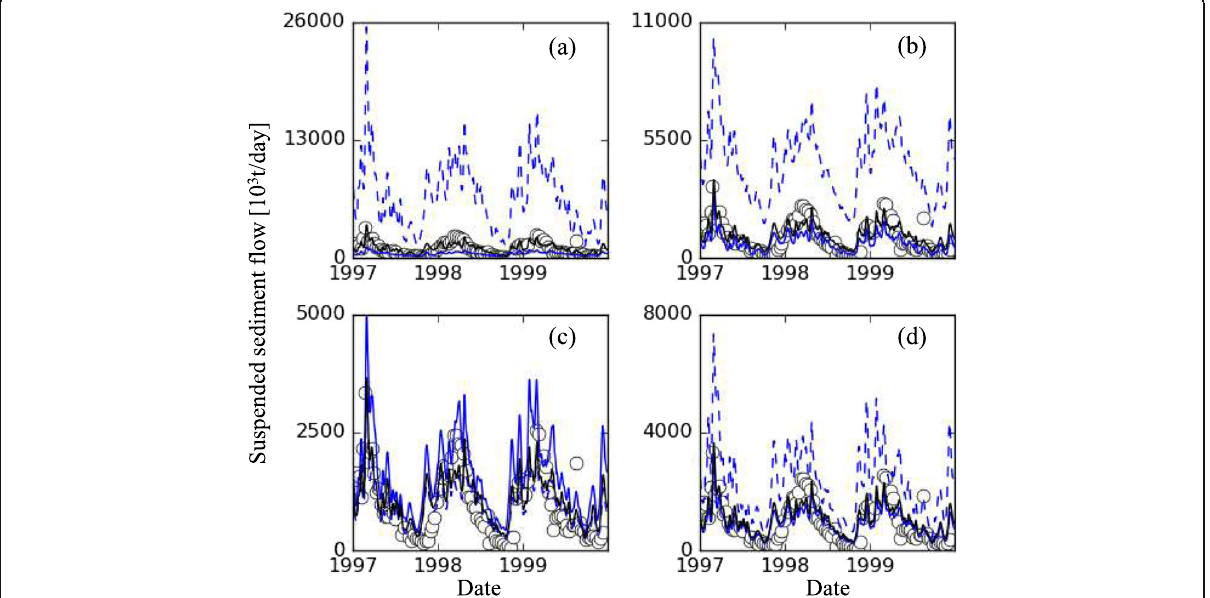
Fig. 9 Daily suspended sediment flow [10 3 t/a] at Obidos station, as estimated from sensitivity experiments for a erosion, b exchange layer, c rising waters, and d suspension. Black circles and solid lines indicate observation and CTL simulations, respectively. Solid and dashed blue lines indicate smaller and larger parameter values,